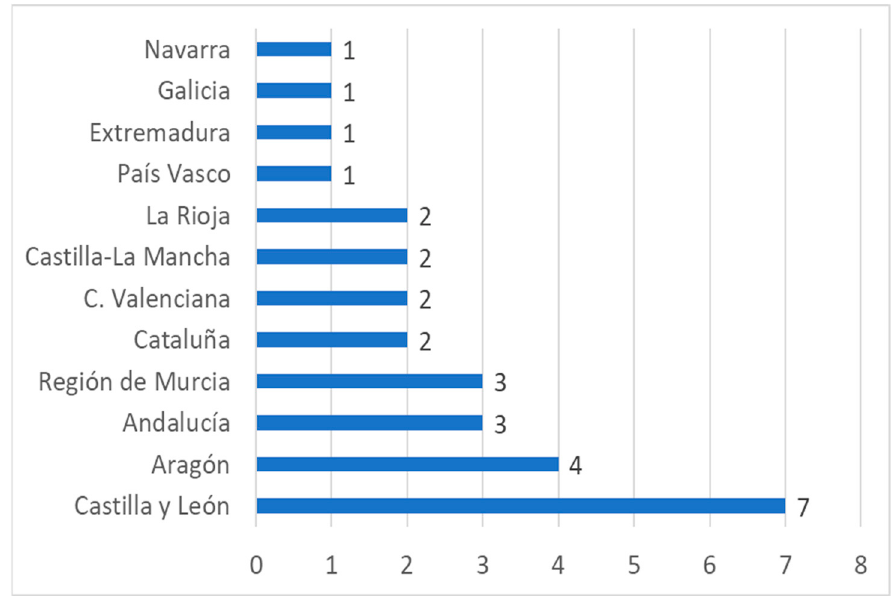
Figure 3. Wine routes in Spain by autonomous community (year 2021). Source: Own elaboration based on data from the Ministry of Agriculture, Fisheries and Food (MAPA) [46].